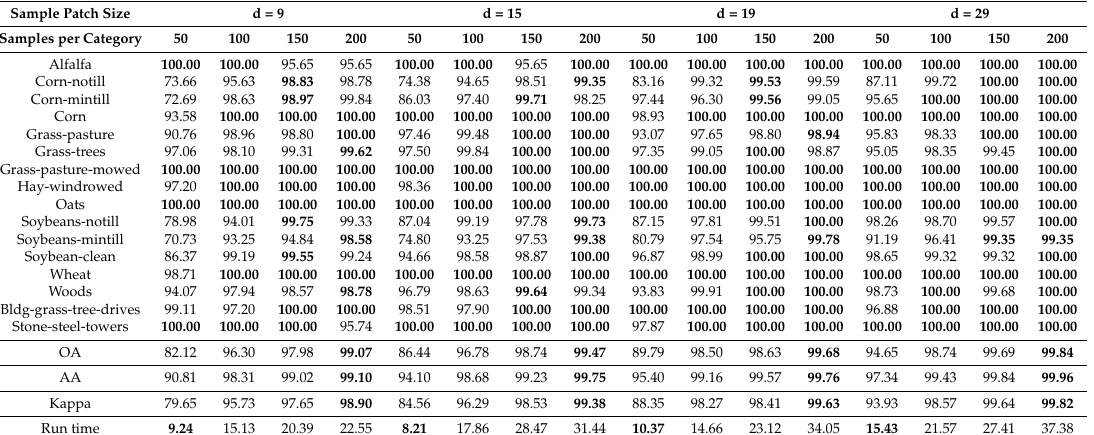
Table 11. Classification accuracies obtained by the proposed spatial-spectral FFPNet (with sample patch sizes d = 9, 15, 19, and 29) for the IP dataset. The values in bold are the best under different sample patch sizes. All results are the average of three runs with maximum epoch = 200 and mini-batch size =